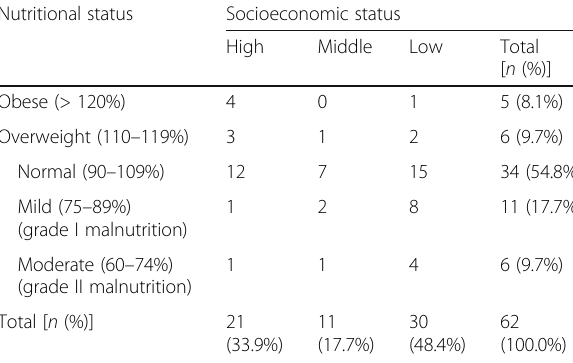
Table 1 Parental socioeconomic status and pre-operative nutritional status of children with obstructive adenotonsillar enlargement